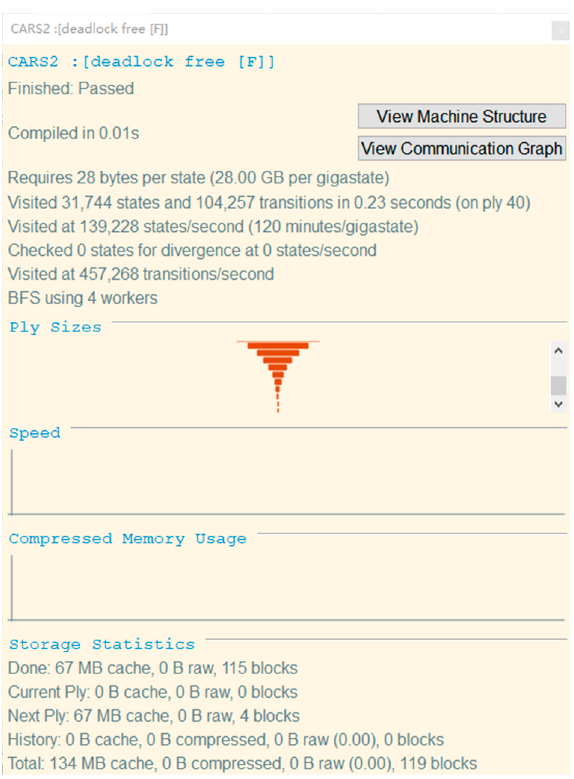
Figure 4. Deadlock ‐ free diagram. Figure 4. Deadlock-free